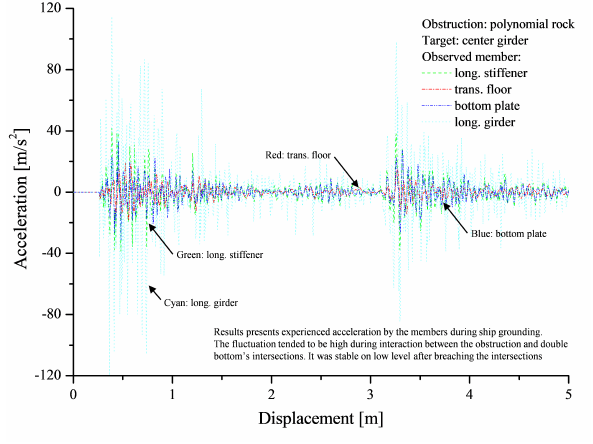
Figure 14: Structural acceleration under grounding action. The se- lected obstruction: polynomial